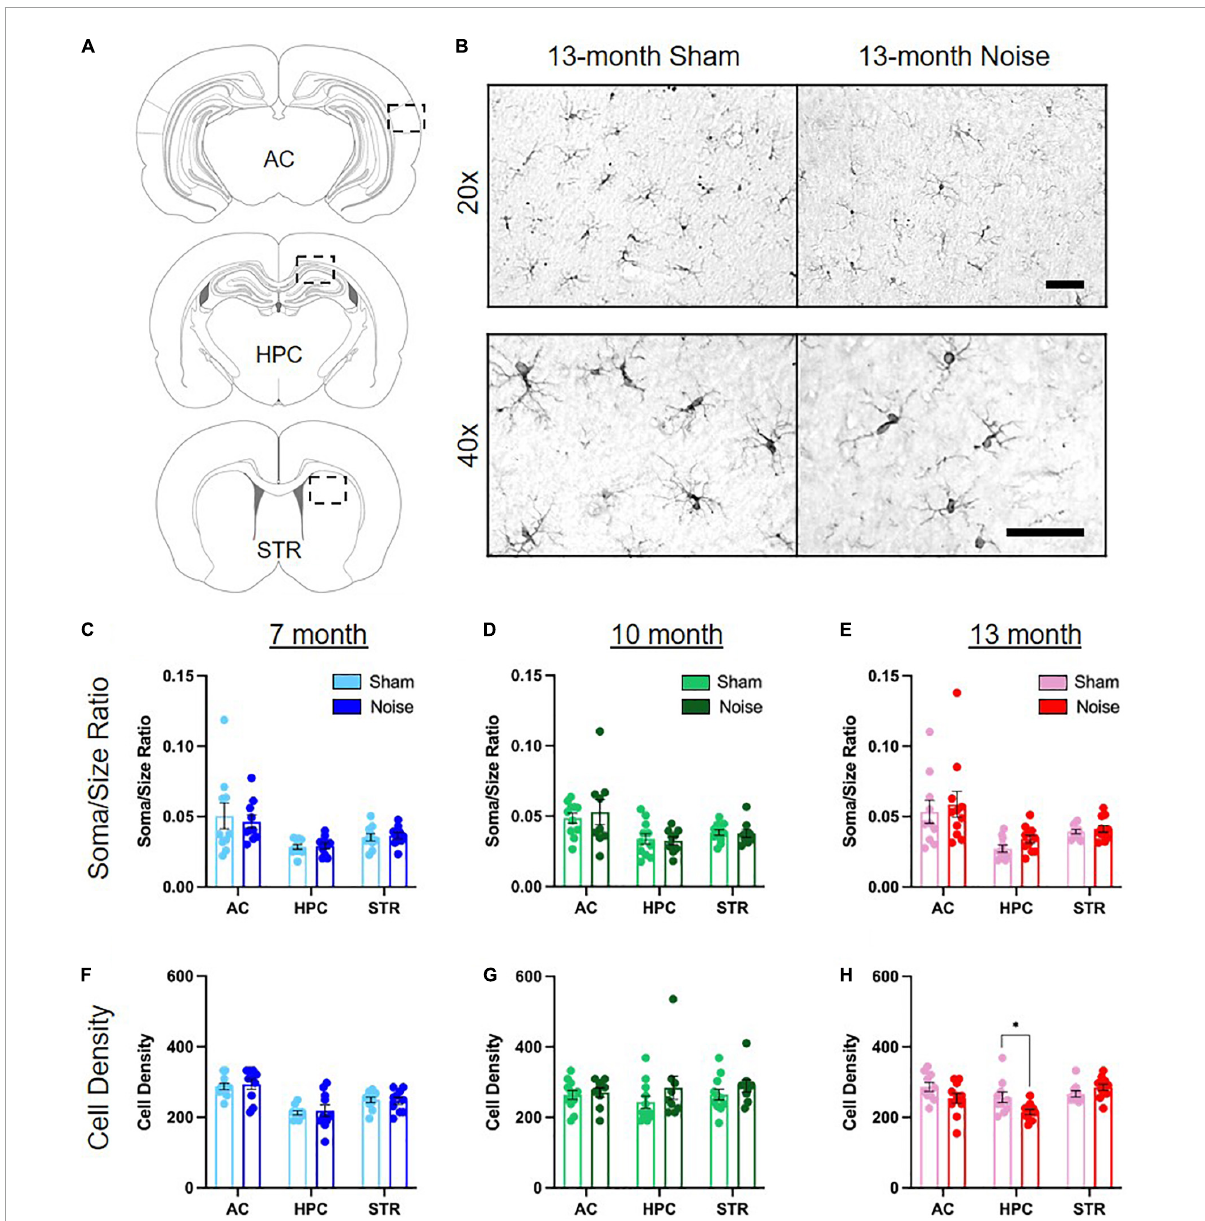
FIGURE5 Noise exposure altered microglial density in the hippocampus, but not the auditory cortex or striatum. (A) Coronal section and outline for the auditory cortex (AC), hippocampal CA1 (HPC), and striatum (STR) regions of interest. (B) Representative 20 × (top row) and 40 × (bottom row) images of Iba1-positive microglia in the hippocampal CA1 of 13-month sham- and noise-exposed rats. Further quantification was performed on 40 × images. See Supplementary Figure 1 for additional images. Scale bar = 50 µ m. (C–E) There was no difference in Iba-1-positive soma/size ratios between sham- and noise-exposed rats in the auditory cortex, hippocampus, or striatum at any age. (F,G) Microglial cell density was not affected by noise exposure in any brain region in 7- and 10-month-old animals. (H) There was a significant decrease in microglial cell density in the hippocampus in noise-exposed rats at 13 months of age, but not in the auditory cortex or striatum (* p bonf < 0.05). n = 7-month (Sham: 4 male, 6 female; Noise: 5 male, 5 female), 10-month (Sham: 6 male, 5 female; Noise: 4 male, 5 female), and 13-month (Sham: 6 male, 4 female; Noise: 6 male, 5 female). Data represent group mean ±